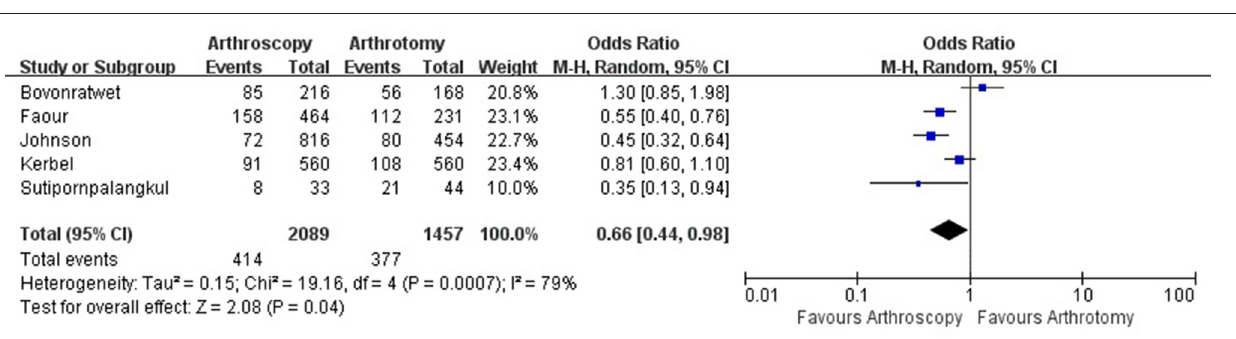
Frontiers in Surgery |